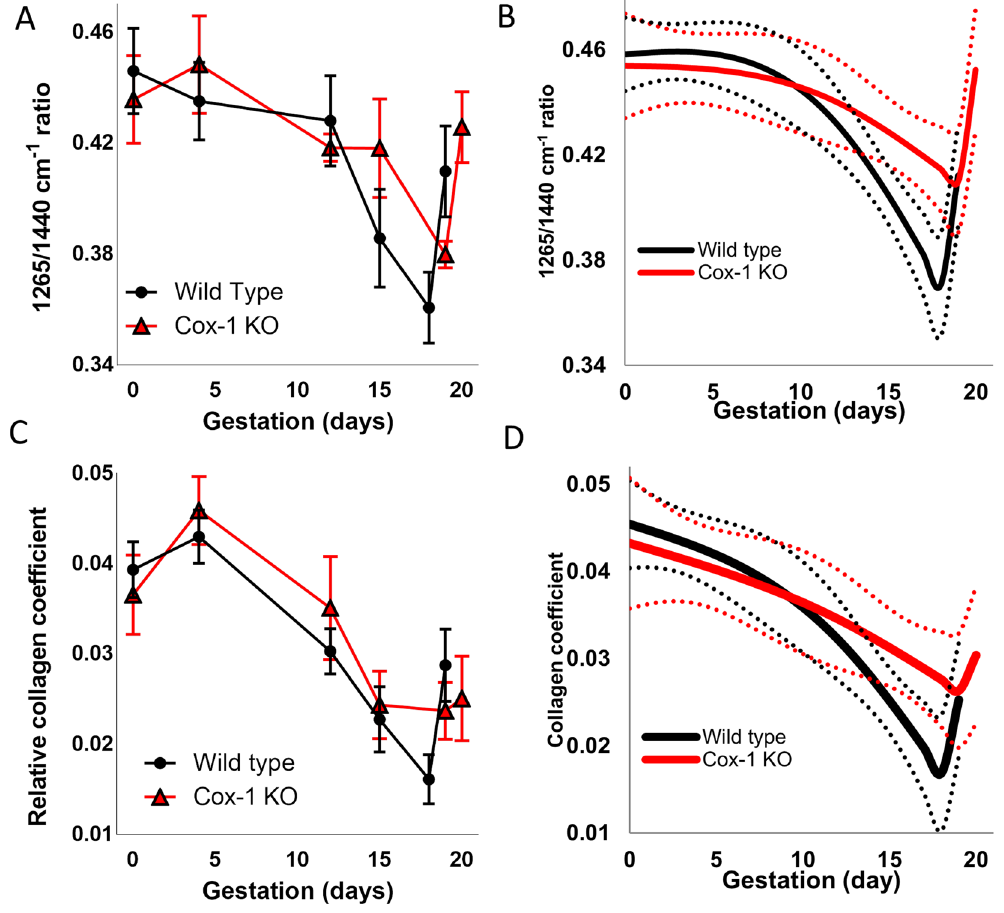
Figure 4. Raman spectra reveal delayed remodeling in the Cox-1 KO mouse at term. Mean ± SEM ( A ) and modeled longitudinal trajectories ( B ) of the 1657 cm − 1 to 1440 cm − 1 peak ratio. Mean ± SEM ( C ) and modeled longitudinal trajectory ( D ) of the non-negative least squares model collagen coefficient as a function of gestation in WT and Cox-1 KO